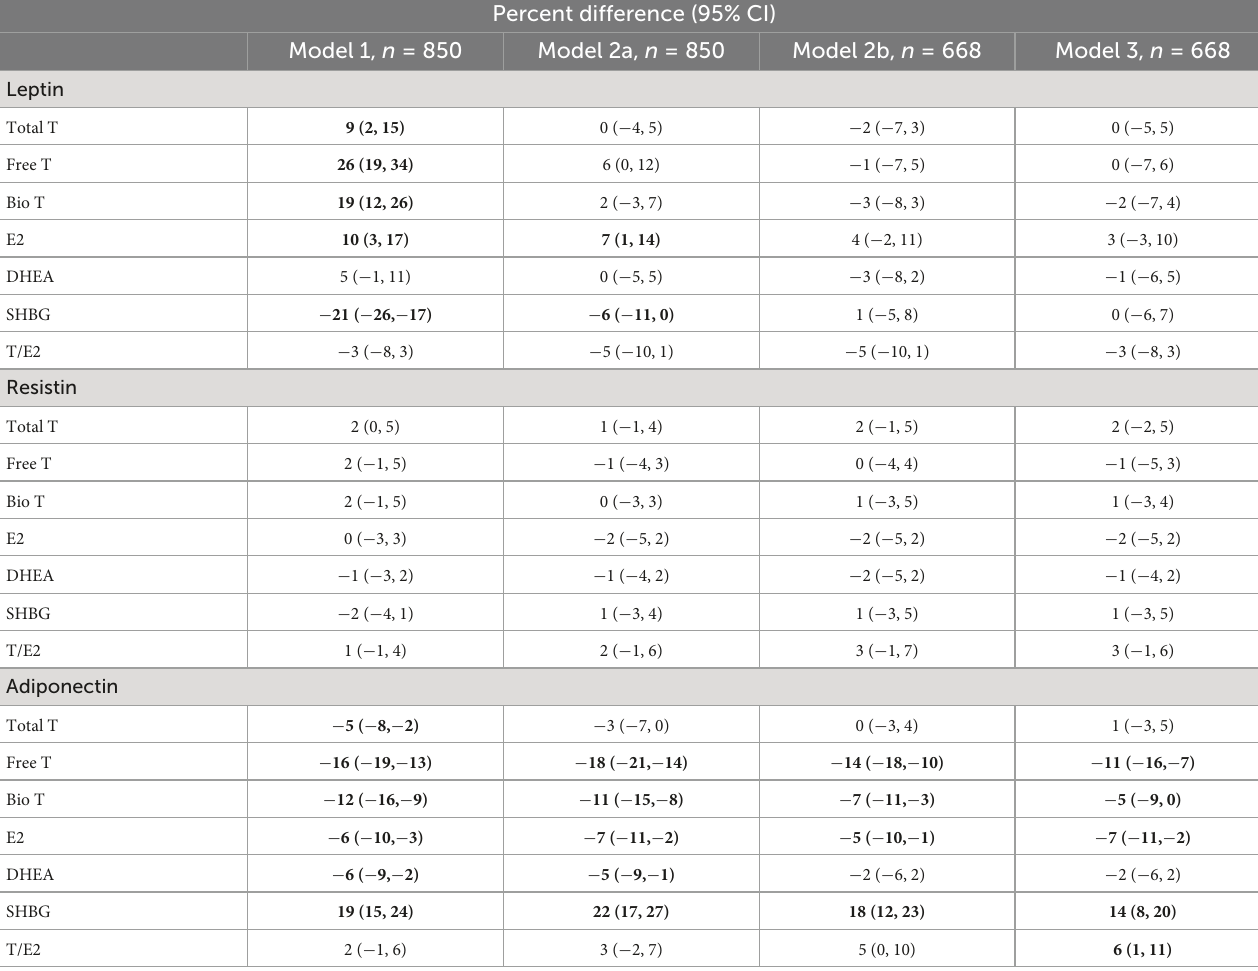
TABLE 2 Multivariable-adjusted association between sex hormones and adipokines in